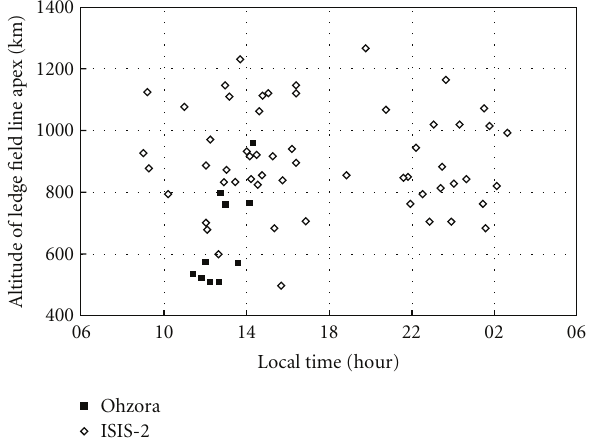
Figure 17: Squares and diamonds indicate the location of the ionization ledge observed from the Ohzora and the ISIS-2 satellites, respectively (from Uemoto et al.